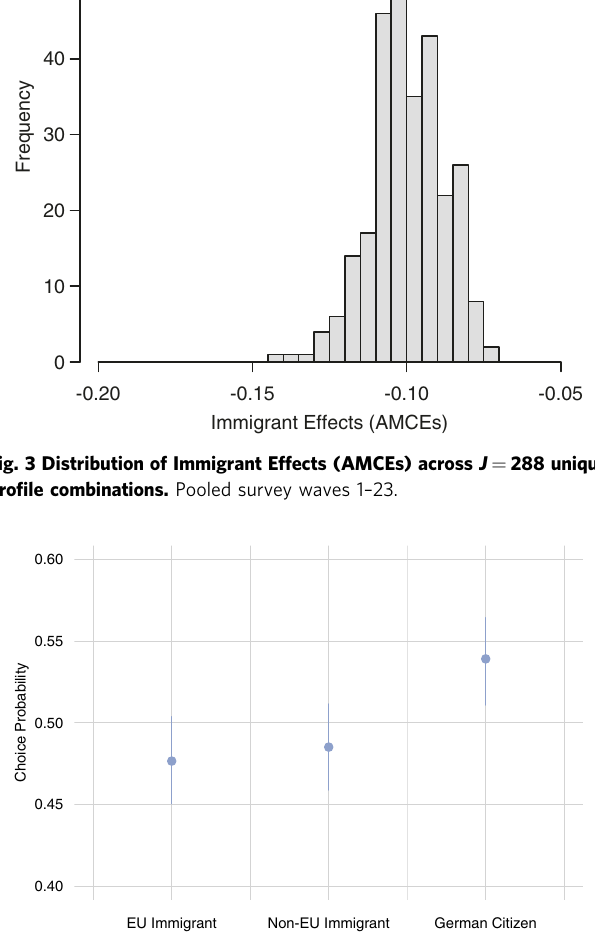
Fig. 4 Comparison across immigrant status — EU migrants, non-EU migrants, German citizens (choice probability and simulated 95% con fi dence intervals). Pooled survey waves 14 –